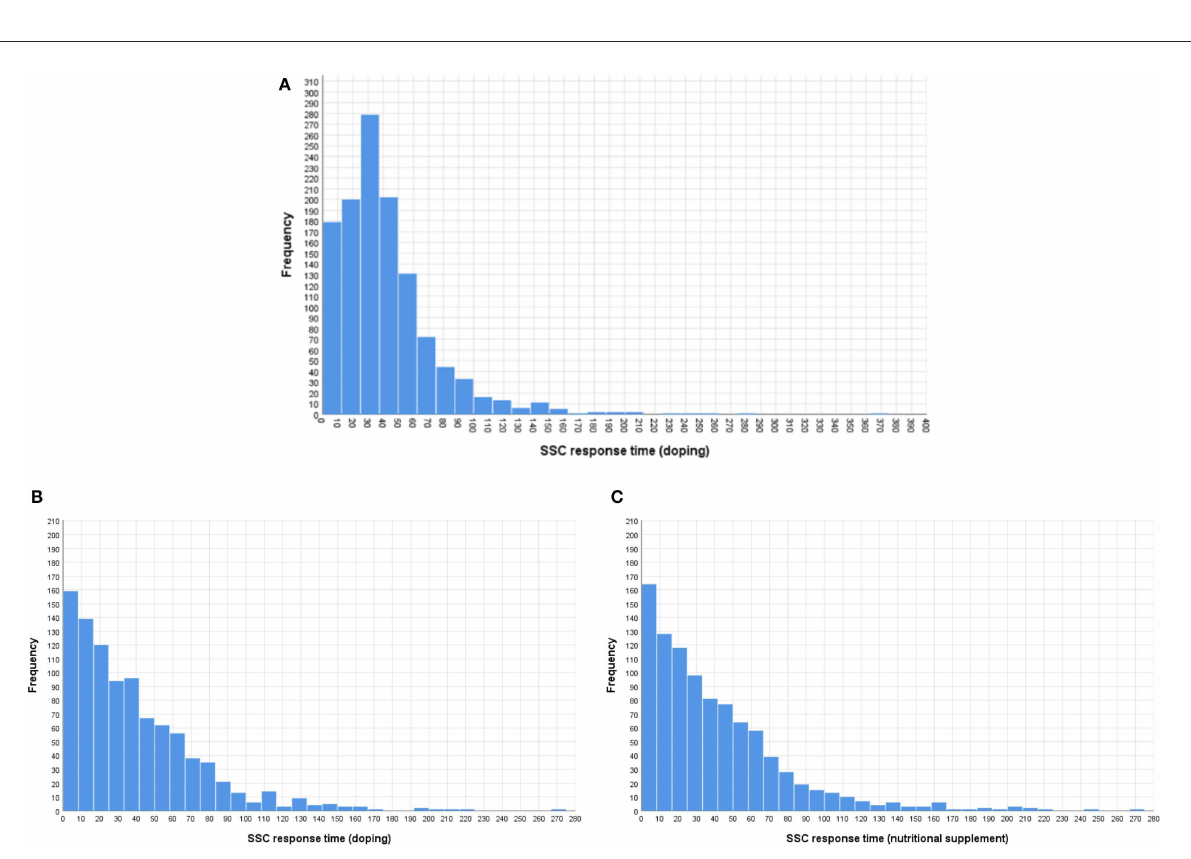
FIGURE1 Response time distributions at WCA [ (A) doping question] and PAG [ (B) doping and (C) herbal, mineral, and/or vitamin supplements